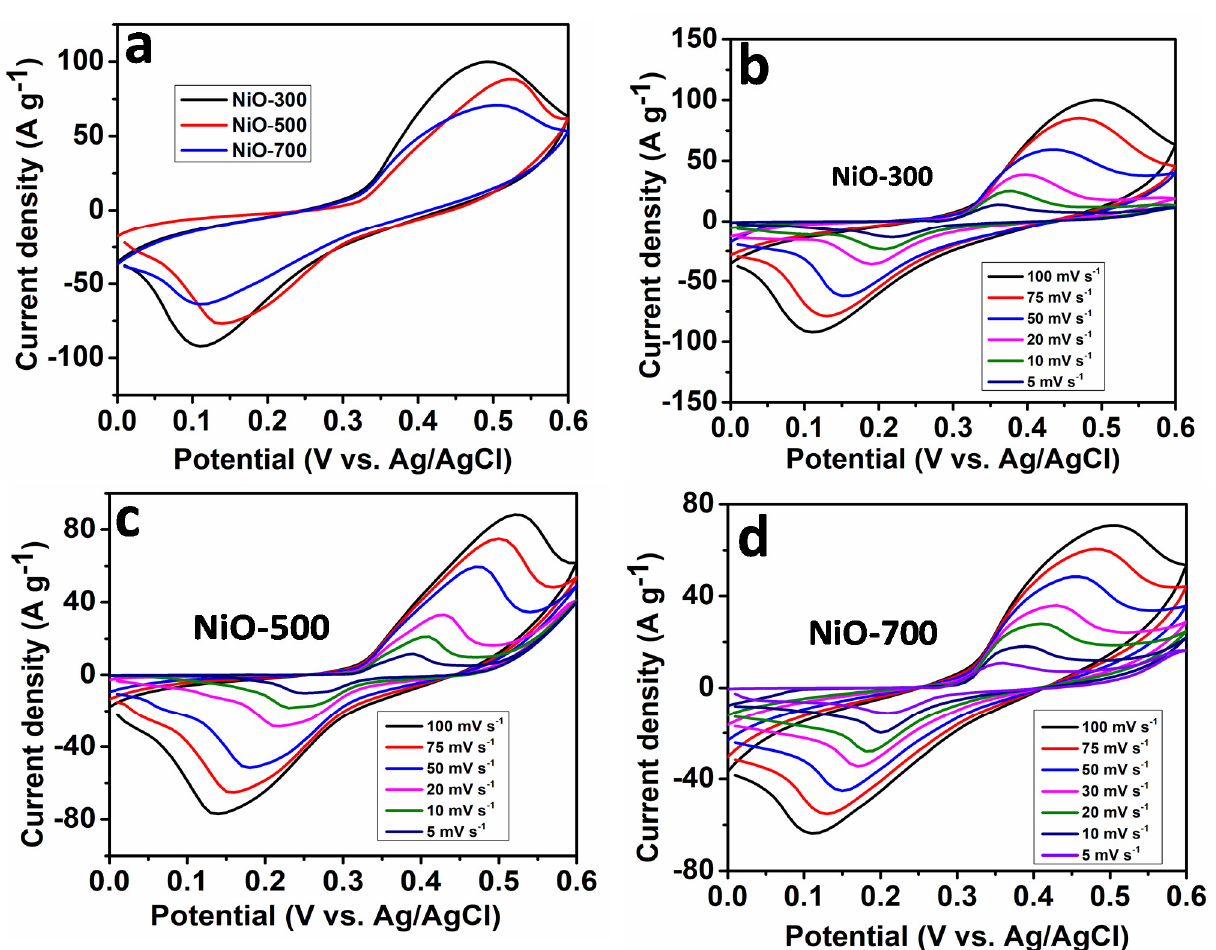
Figure 5. ( a ) Comparative CV profile of three different NiO electrodes; ( b – d ) CV profiles of NiO-300, NiO-500, and NiO-700 at various sweep rates, respectively.